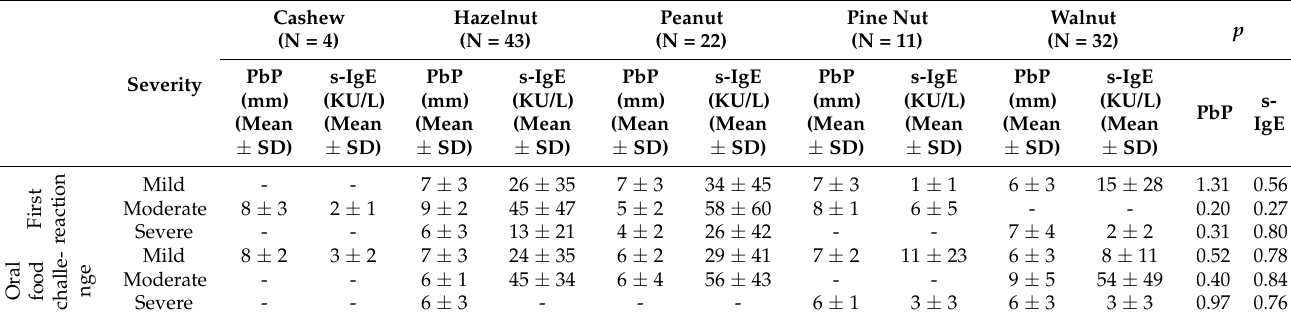
Table 4. Prick by prick and serum-specific IgE levels to the respective nuts, severity of the first nut reaction, and severity of the positive oral food challenge.